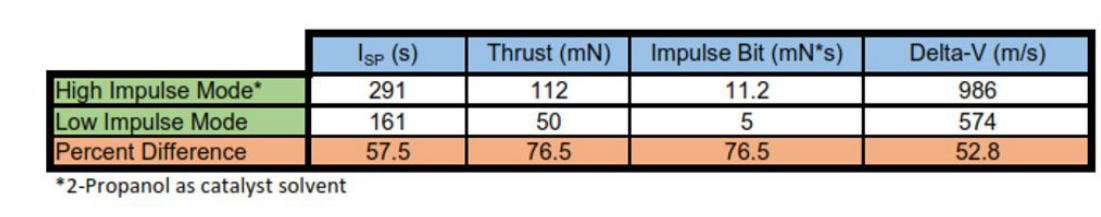
Table 1. Operating parameters for high and low impulse modes. I sp calculations are performed assuming a perfect converging–diverging nozzle, thrust is calculated using flow rates that will produce 50 mN of thrust during low impulse operation, impulse bit is calculated using a 10 ms valve actuation time, and Delta-V is calculated for a 3U CubeSat with 1U dedicated to fuel and